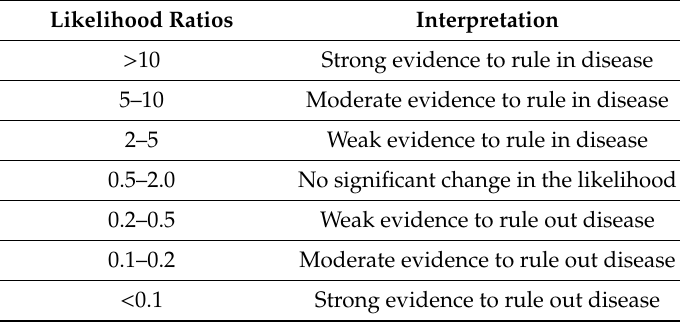
Table 2. Clinical significance of similarity